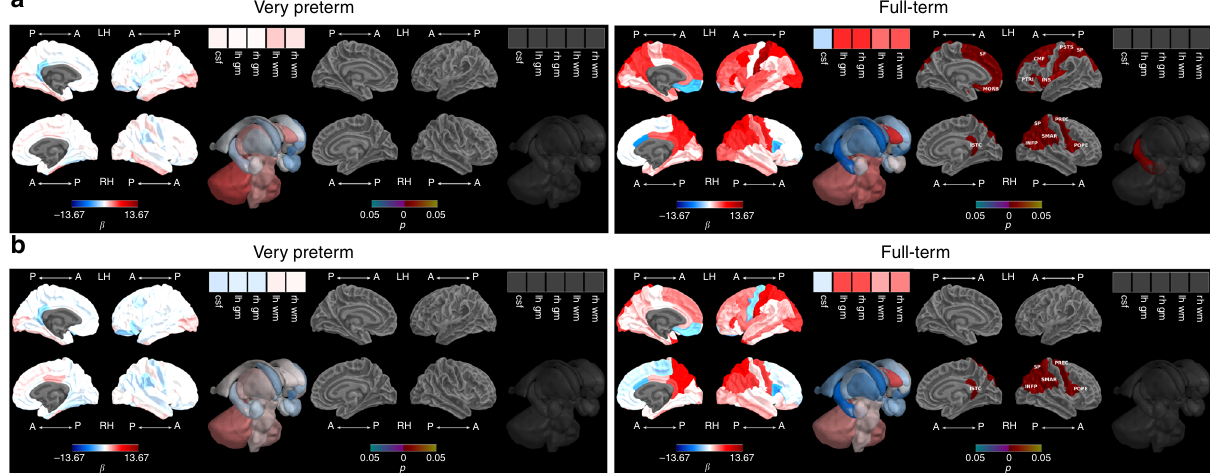
Fig. 5 Intelligence and brain growth from 7 to 13 years. a Adjusting for sex and age at IQ assessment and b additionally adjusting for total brain volume growth and social risk. Note: IQ-by-time regression coef fi cients from linear regression models ( β ) in blue refer to negative associations (slower growth associated with higher IQ scores) and in red refer to positive associations (faster growth associated with higher IQ scores), with darker coloured regression coef fi cients indicating stronger signi fi cance; p values are false discovery rate corrected and darker coloured p values indicate stronger associations; Boxes in the top right corner of the fi gures represent global brain volumes. A = anterior, P = posterior, LH = left hemisphere, RH = right hemisphere, csf = cerebrospinal fl uid, gm = grey matter, wm = white matter, CMF = caudal middle frontal, INFP = inferior parietal, INS = insula, ISTC = isthmus cingulate, MORB = medial orbitofrontal, POPE = pars opercularis, PTRI = pars triangularis, PSTS = postcentral, PREC = precentral, SF = superior frontal, SP = superior parietal, SMAR =